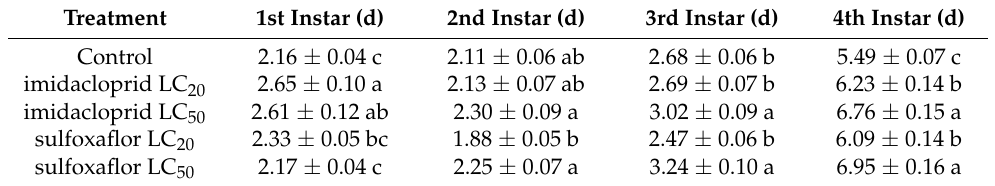
Table 6. Mean ( ± SE) values of stage-specific larval developmental duration of the progeny of Harmonia axyridis females exposed to imidacloprid and sulfoxaflor and their LC 50 and LC 20 estimated for the target pest, Aphis gossypii . Values followed by different letters, within the same column, indicate significant differences at p < 0.05